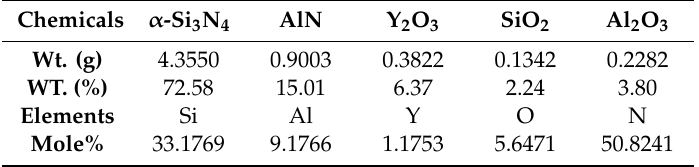
Table 1. Weight (in gram) and molar percentage of precursors to synthesize 6 g of sample (composition: m = 1.0, n = 1.6) XX-1016 Series, Y m / 3 Si 12-( m + n ) Al ( m + n ) O ( n ) N 16 − n = Y 0.333 Si 9.4 Al 2.6 O 1.6 N 14.4